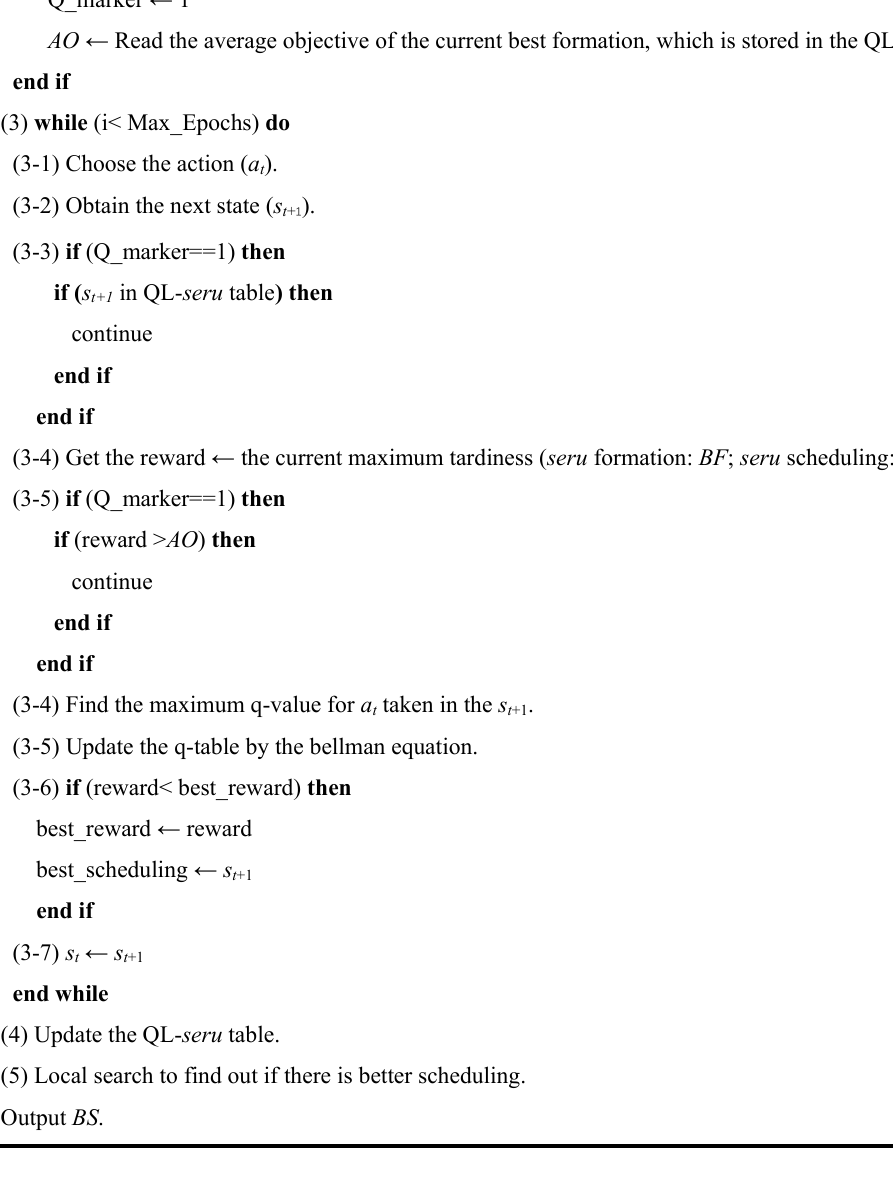
action in reinforcement learning,